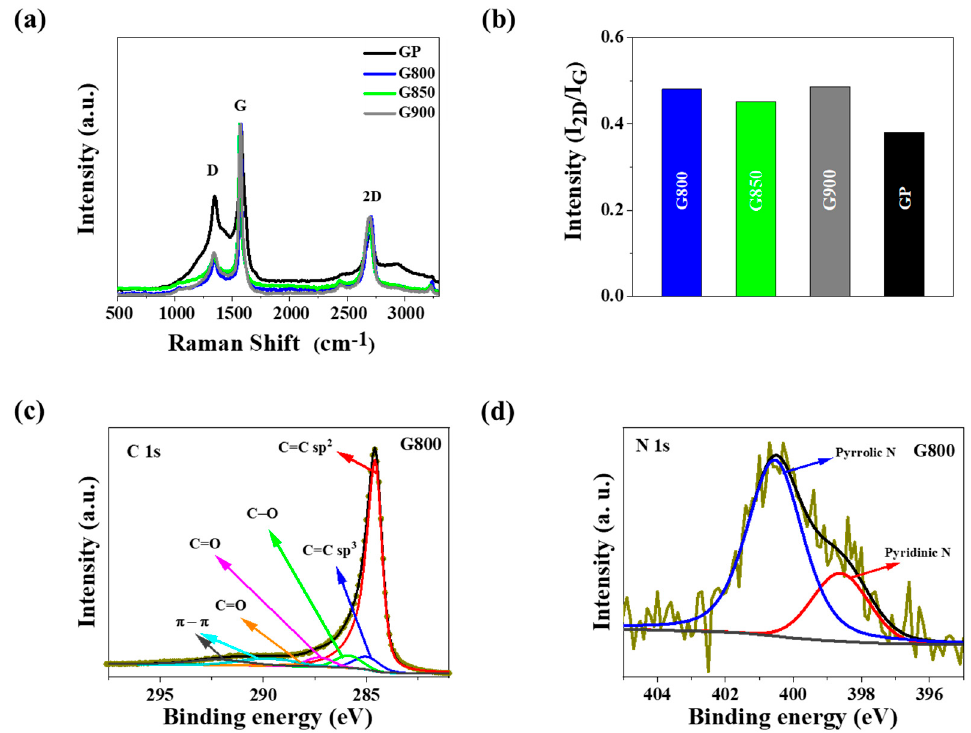
Figure 3. ( a ) Raman spectra and ( b ) intensity ratio of pristine graphite powder (GP) and N-doped exfoliated graphene obtained in GX series; ( c ) X-ray photoelectron spectroscopy (XPS) spectra of C1s and ( d ) N1s for G800 sample.